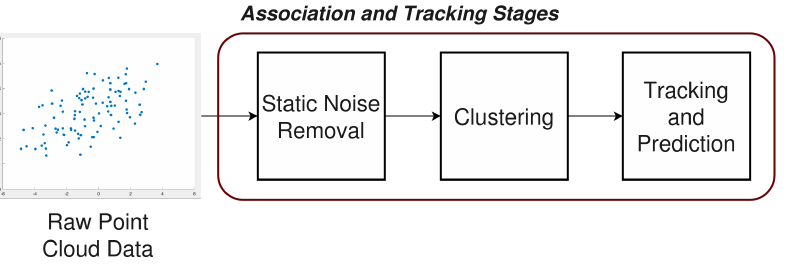
Figure 5. Generalized stages of association and tracking in a mmWave tracking architecture